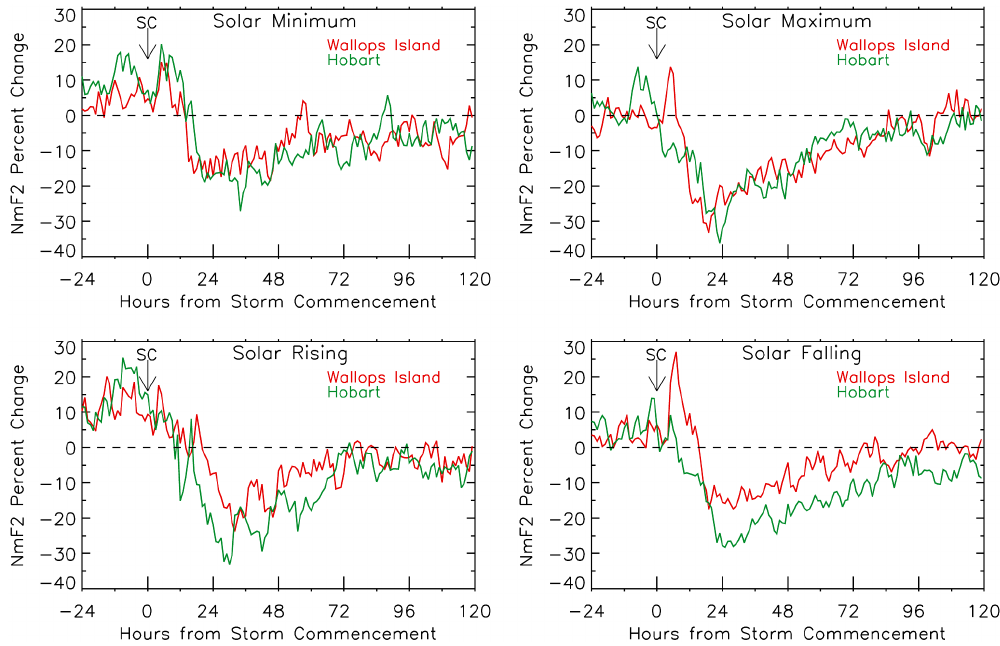
Fig. 9. Average storm-time patterns for Wallops Island and Hobart sorted by phases within solar cycle #20 as defined in Fig. 1. Panels (a) and (b) give results for solar minimum and maximum periods, while panels (c) and (d) give results for the rising and falling portions of the solar